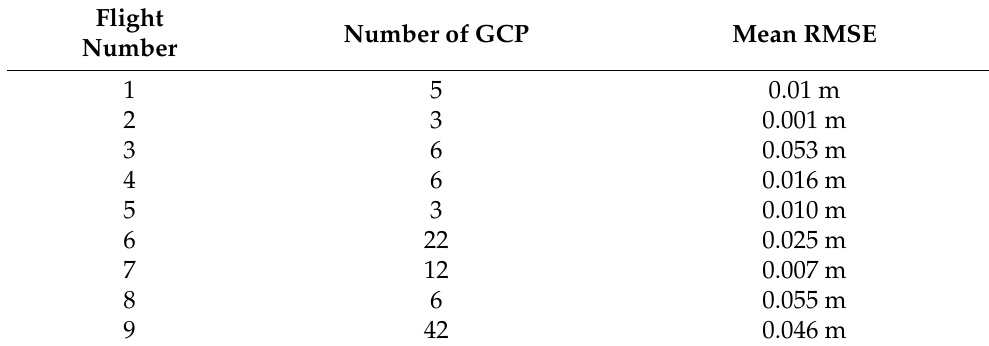
Table 6. UAS SfM